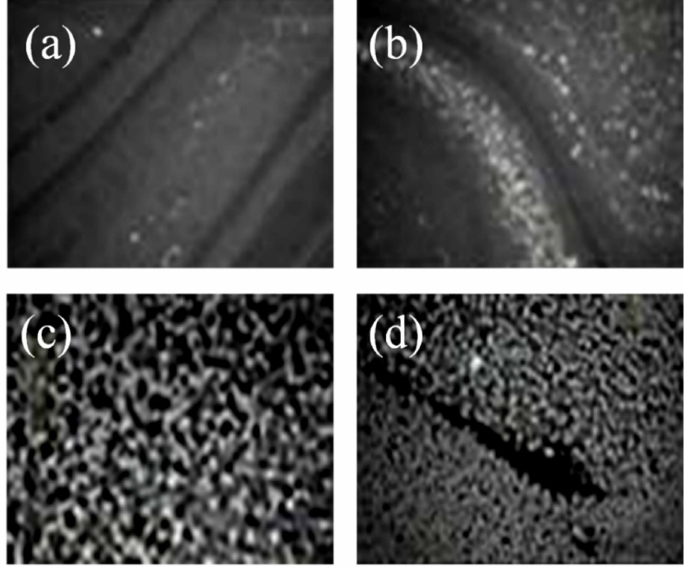
Figure 3. BAM images (width: 500 µ m) of the 2a compound at different surface pressures: ( a ) 0.5 mN ¨ m ´ 1